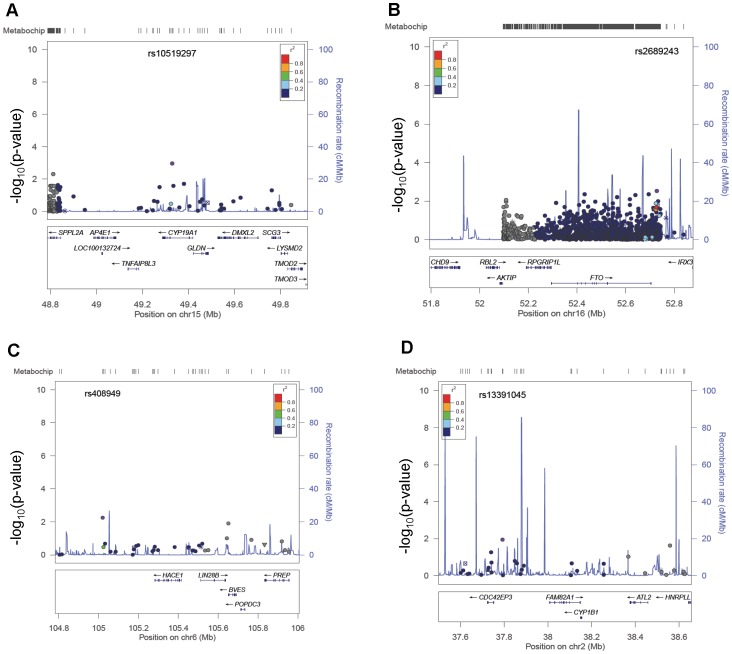
Regional Association Plots for Age at Menarche in African American women in the PAGE Study.Locus Zoom plots for selected gene regions in age at menarche analysis. Vertical axis is –log10 of the p-value, the horizontal axis is the chromosomal position. Each dot represents a SNP tested for association with age at natural menopause in 1,860 African American women from the PAGE Study. Approximate linkage disequilibrium between the most significant SNP, listed at the top of each plot, and the other SNPs in the plot is shown by the r2 legend in each plot. (A) Locus Zoom plot for the CYP19A1 region, with rs10519297 the most significant SNP in the region. (B) Locus Zoom plot for the FTO region; rs2689243 was the most significant SNP in the plot region. (C) LIN28B region Locus Zoom plot; rs408949 was the most significant SNP in the plot region. (D) Locus Zoom plot of the CYP1B1 region; rs13391045 was the most significant SNP in the plot region.